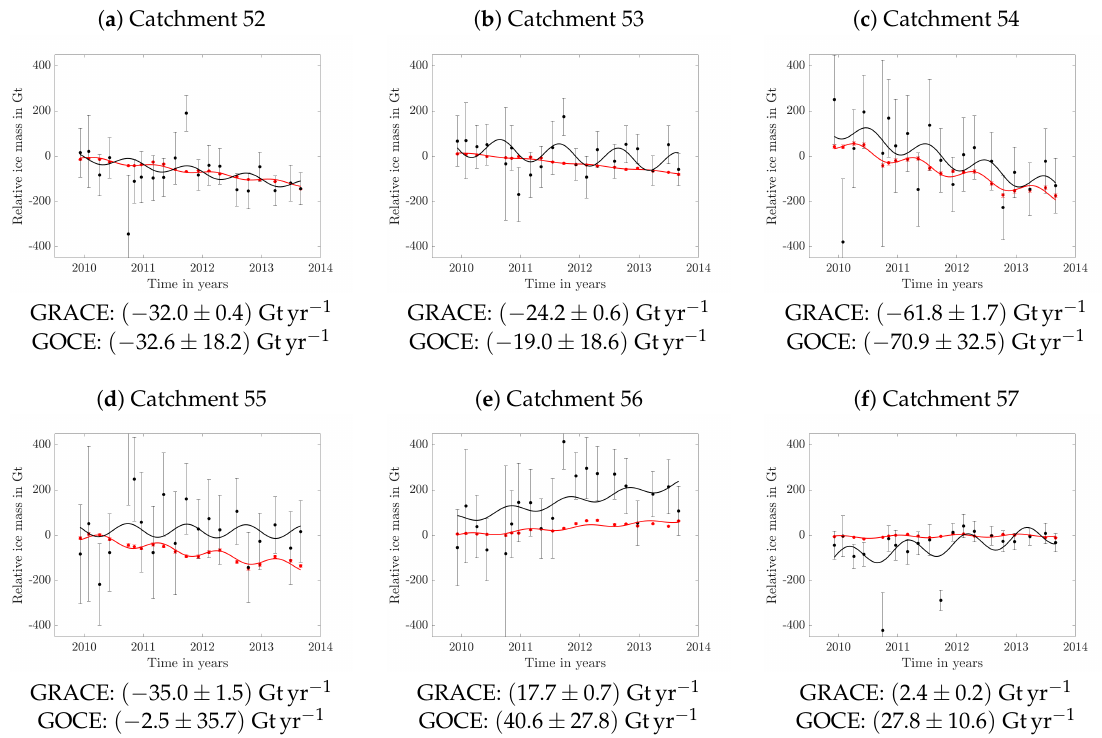
Figure 13. Time series of relative ice masses of the six largest glacier catchments in Greenland (see Figure 7) over the four-year GOCE data period. The ice masses are derived from GOCE SGG-only (black) and GRACE-only (red, models from [8]) bi-monthly SH d/o 60 models, by only using the non-polar gap wedge SH coefficients of degrees 10 to 60. The reference model subtracted is the static and trend part of the GOCO06s model [9], evaluated on 1 October 2009. For each glacial